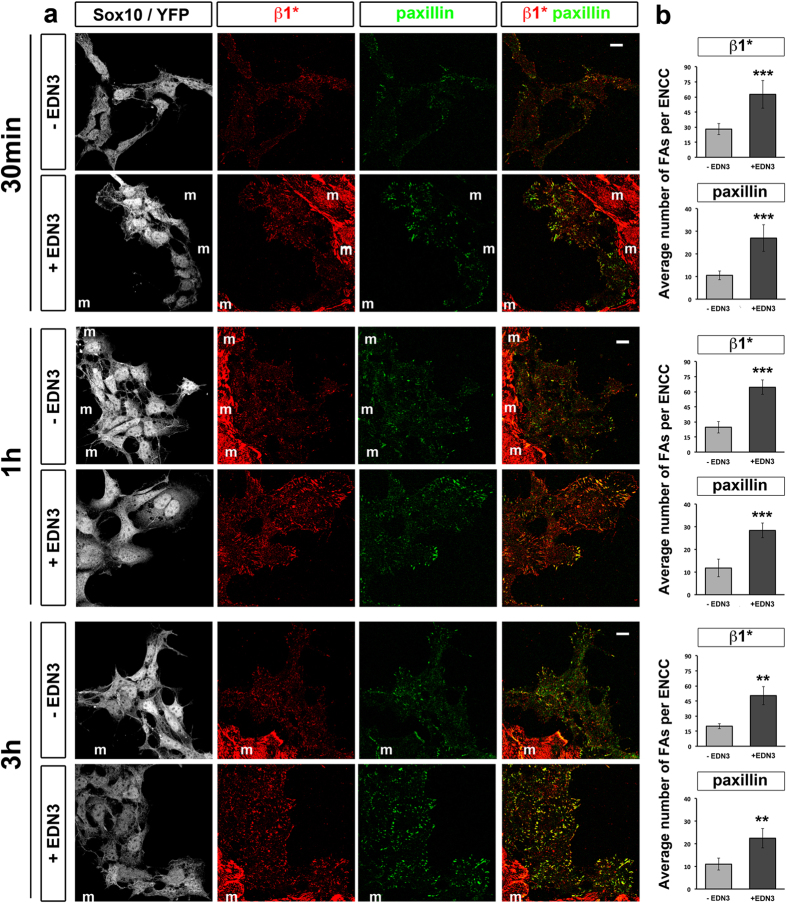
Time-course of the response of ENCCs to short exposure to EDN3.(a) Confocal images of control gut explants cultured overnight on FN in control medium prior to EDN3 treatment for 30 min, 1 h or 3 h, immunolabeled for Sox10 and YFP (ENCCs), activated β1-integrin (β1*), and paxillin. The letter m refers to mesenchymal cells (Sox10−/YFP−). Merged images for β1* and paxillin are shown in the right panels. (b) Average number of β1*- and paxillin-positive FAs per ENCC after treatment with or without EDN3 for 30 min, 1 h, and 3 h. The number of cells analysed under control and EDN3 conditions was n = 277 and n = 208 after 30 min; n = 382 and n = 255 after 1 h; and n = 355 and n = 327 after 3 h of treatment, respectively. Error bars indicate the SEM; **p < 0.01; ***p < 0.001. Scale bars = 10 μm.